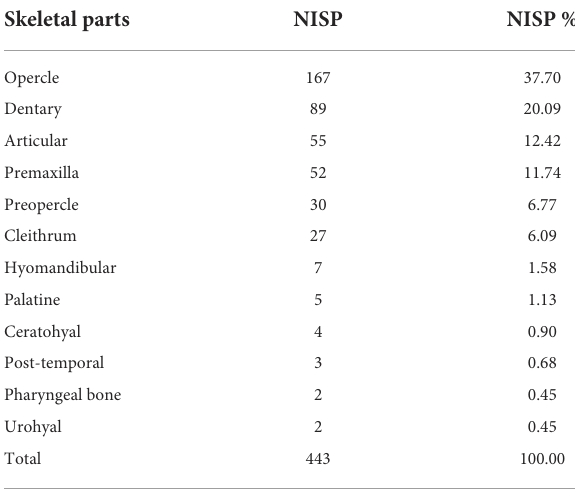
TABLE 4 Distribution of Chinese sea bass skeletal parts at the Guye site (in descending order of